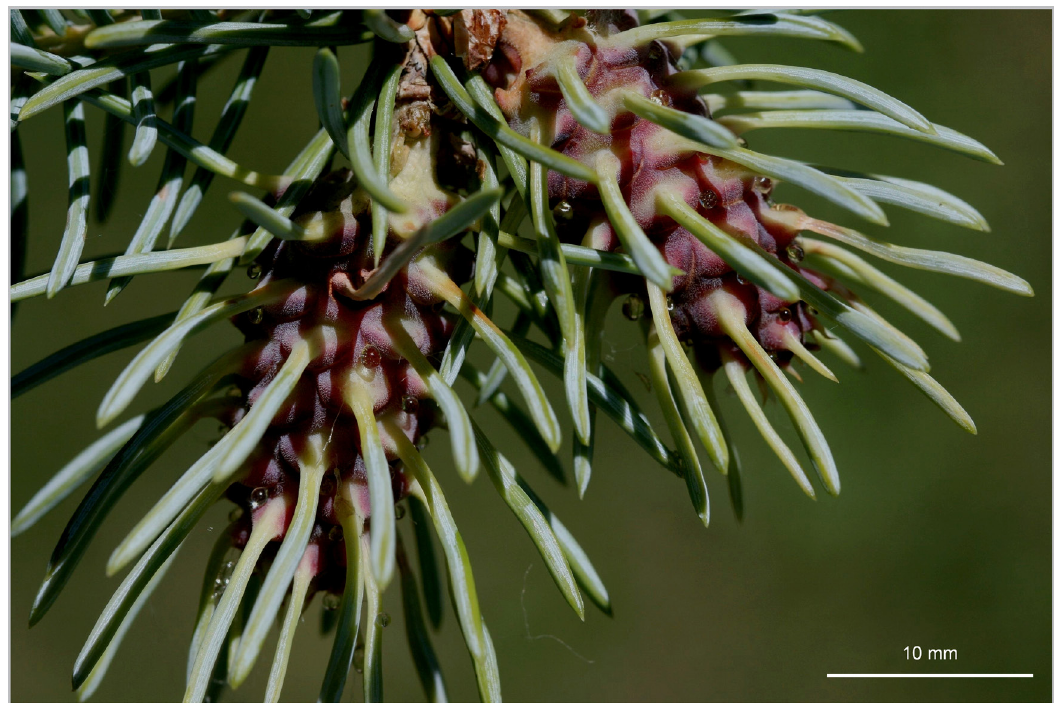
Fig. 15. Adelges (Gilletteella) cooleyi (Gillette, 1907). Galls on Picea pungens . Photo Whitney Cranshaw, Colorado State University, Bugwood.org (CC BY 3.0 US, https://creativecommons.org/licenses/by/3.0/ us/, downloaded via http://www.forestpests.org/vd/images/5422254-SMPT.jpg).